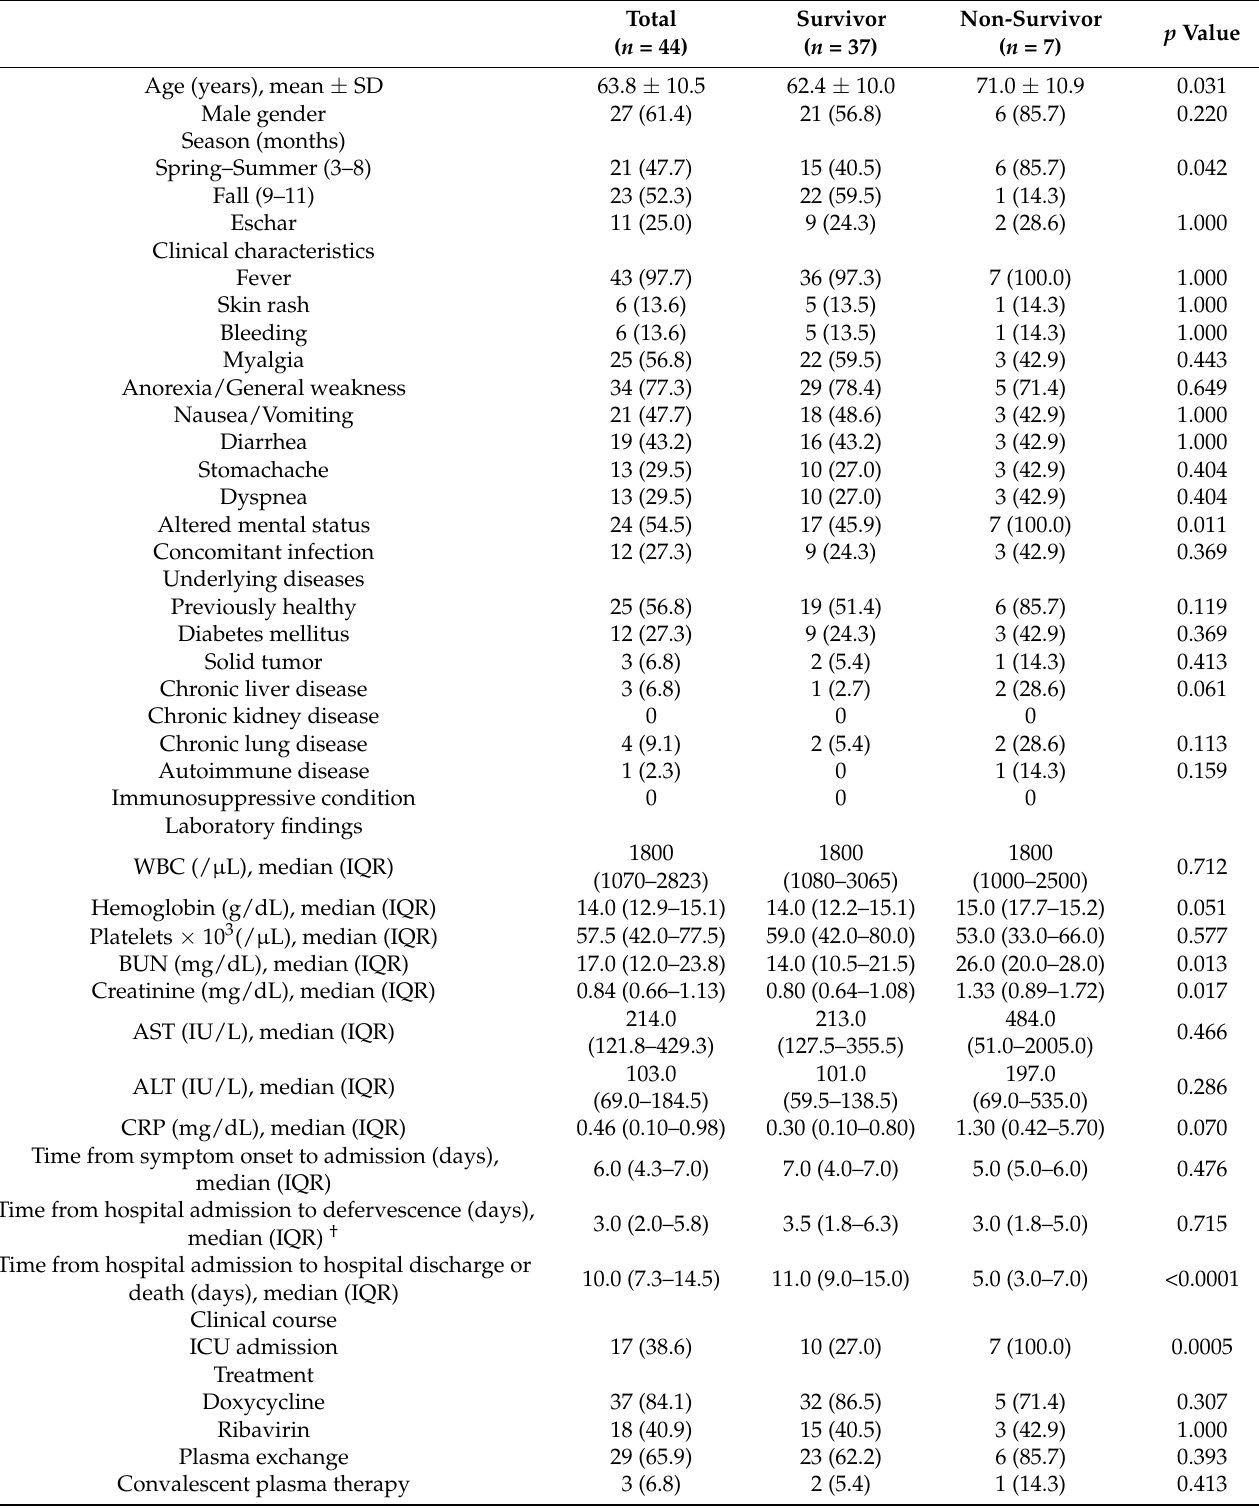
Table 1. Baseline characteristics of the study patients with